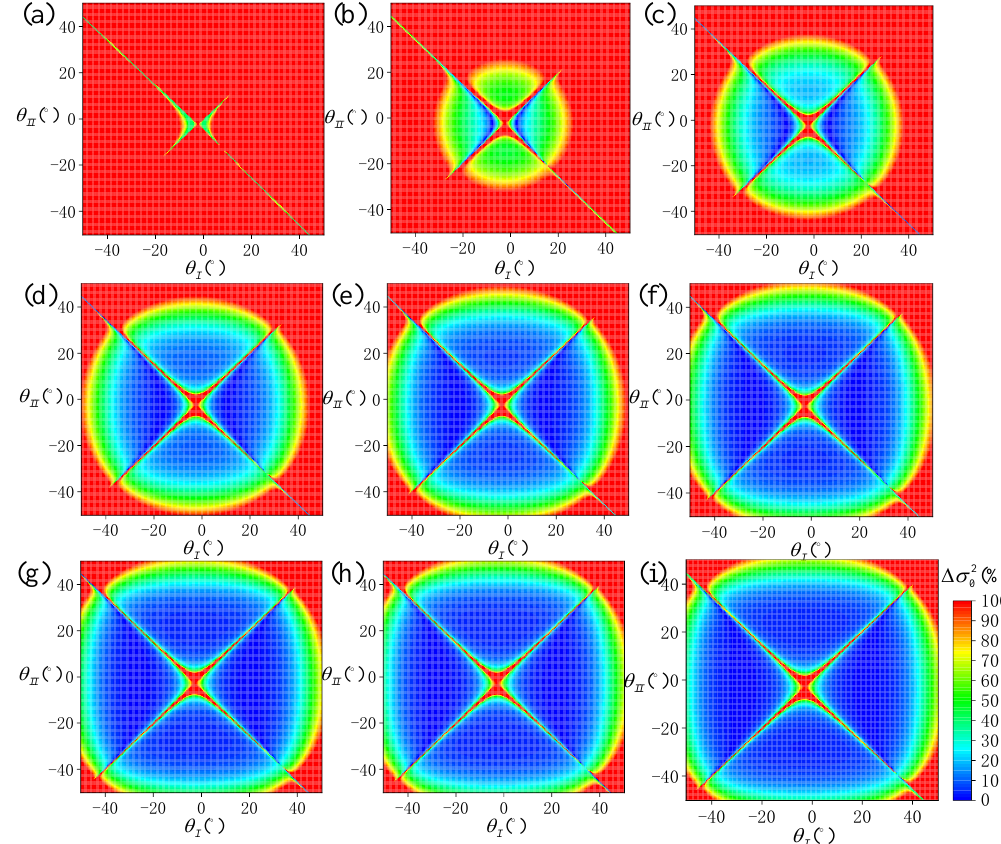
Figure 4. Distribution of sea surface roughness (SSR) estimation error ( ∆𝜎 02 ) simulated under each SVA combination ( 𝜃 𝐼 , 𝜃 𝐼𝐼 ) at different pointing angles: ( a ) P = −24°, ( b ) P = −18°, ( c ) P = −12°, ( d ) P = −6°,